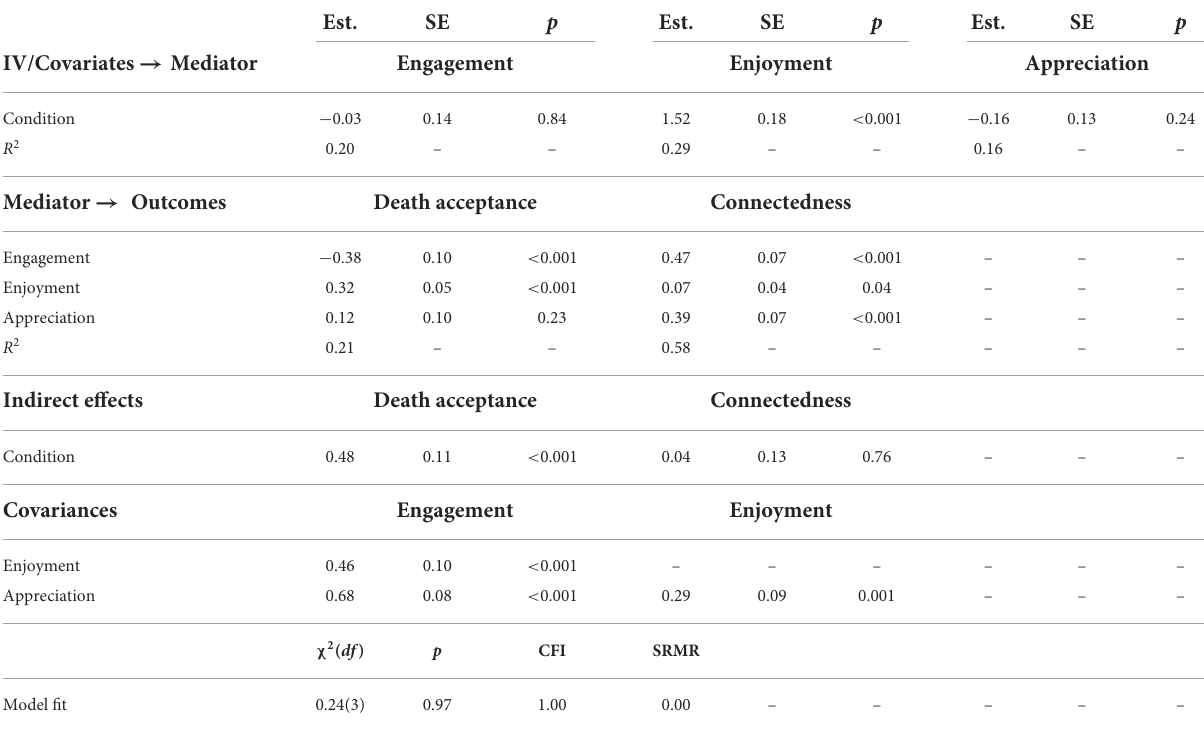
TABLE 3 Estimates, covariances, and model fit for hypothesized path